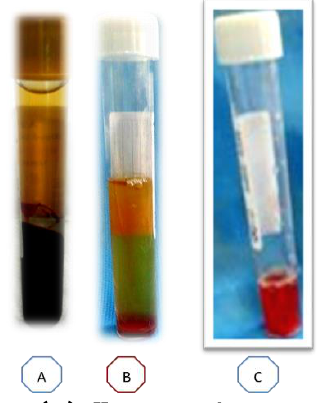
Figure 1: (A) Illustrates the separation of plasma from erythrocyte. (B) Illustrates PRP and PPP. (C) Illustrates PRP. Operative